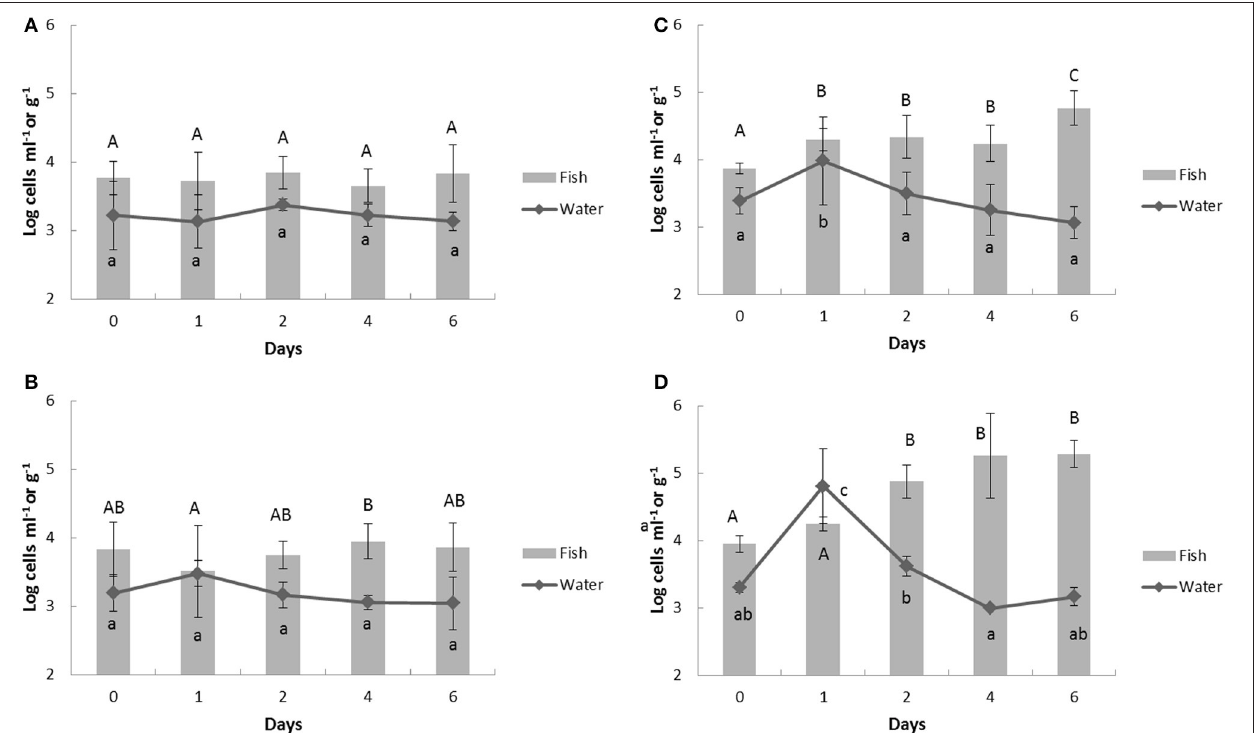
FIGURE 2 | Change of total bacteria counts in aquaculture water and fish detected by multiplex real-time PCR assay in response to heat- inactivated Vibrio spp. challenge. Bold (A) control group; (B) group 2; (C) group 3; (D) group 4. The Vibrio spp. were challenged in the aquaculture water at day 1 and the samples were collected at 24 h before the challenge (day 0), 1 h after challenge (day 1), and further 2, 4, 6 days. Upper case represents significantly different grouping among fish samples and lower case shows the significant grouping between water samples by Tukey test.